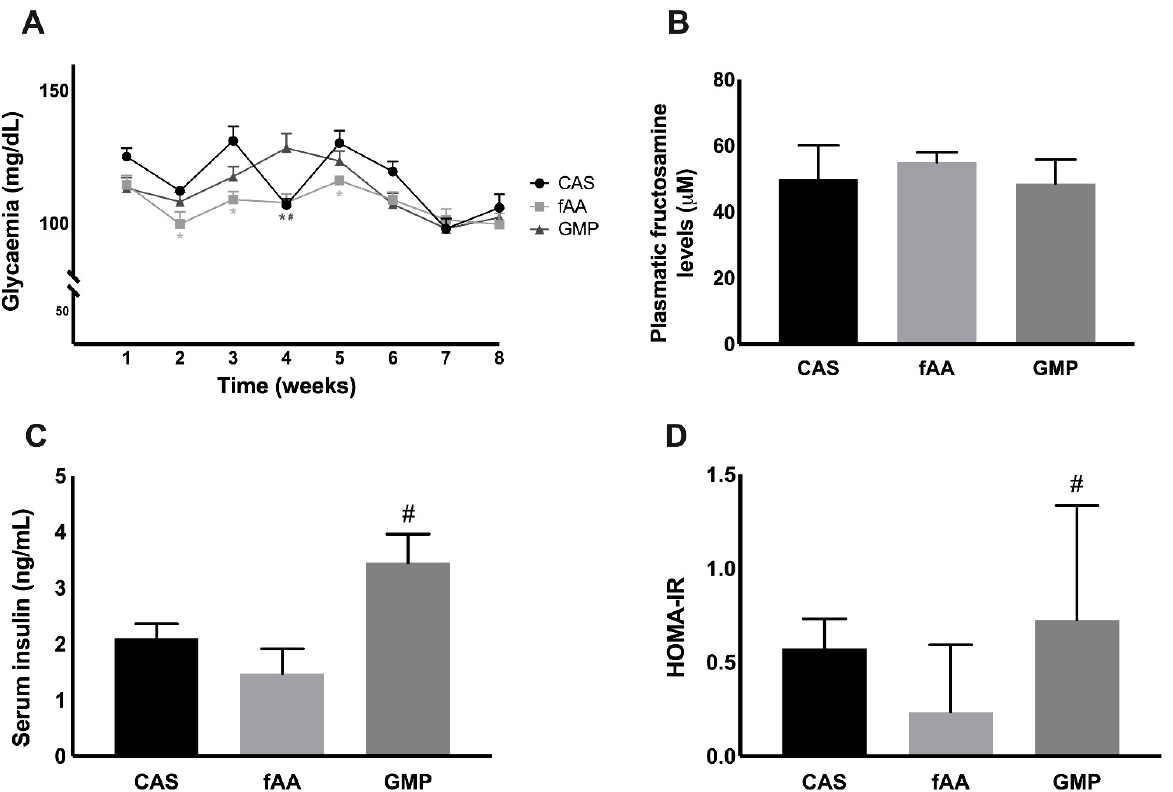
Figure 2. Glycaemia ( A ) of Wistar rats over the 8-week feeding period. Data are presented as mean ± SEM ( n = 8/group). Two-way ANOVA with repeated measures followed by Bonferroni’s post-hoc test was performed. * p < 0.05 vs. CAS; # p < 0.05 vs. fAA. Plasmatic fructosamine ( B ) in the 3 study groups. Data are presented as mean ± SEM ( n = 8/group). One-way ANOVA with Bonferroni’s post-hoc test was performed. Serum insulin ( C ) in the 3 study groups. Data are presented as mean ± SEM ( n = 6/group). One-way ANOVA with Bonferroni’s post-hoc test was performed. # p < 0.05 vs. fAA. HOMA-IR ( D ) in the 3 study groups. Data are presented as median (P25-P75) ( n = 6/group). Kruskal–Wallis with Dunn’s post-hoc test was performed. # p < 0.05 vs. fAA. CAS: casein; fAA: free amino acids; GMP: glycomacropeptide; HOMA-IR: homeostasis model assessment for insulin